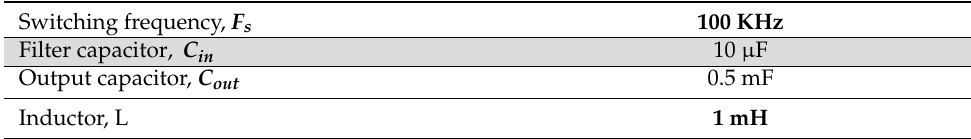
Table A1. Parameters of boost converter.